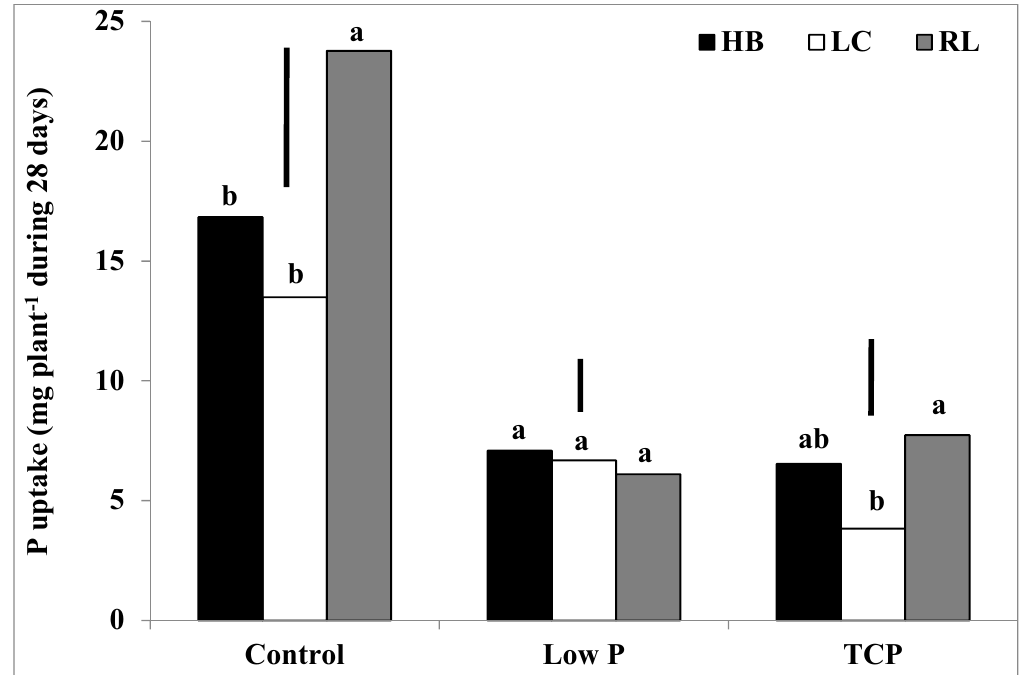
Figure 2. Phosphorus uptake in 28-days old potato seedlings grown in modified Hoagland solution with different P bioavailabilities. Histograms with different letters in the same treatment are different at p < 0.05. Control: 10 mg L − 1 P as water soluble P, NaH 2 PO 4 ; Low P: 1 mg L − 1 P as water soluble P, NaH 2 PO 4 ; and 286 mg L − 1 TCP, tri-calcium phosphate, Ca 3 (PO 4 ) 2 as sparsely soluble P with 2,286 mg L − 1 laboratory grade Ca 3 (PO 4 ) 2 . HB: ‘Harley Blackwell’; LC: ‘La Chipper’; RL: ‘Red LaSoda’. The bars are the values of LSD 0.05, 2 for the plant biomass of the control, low P and TCP, respectively.